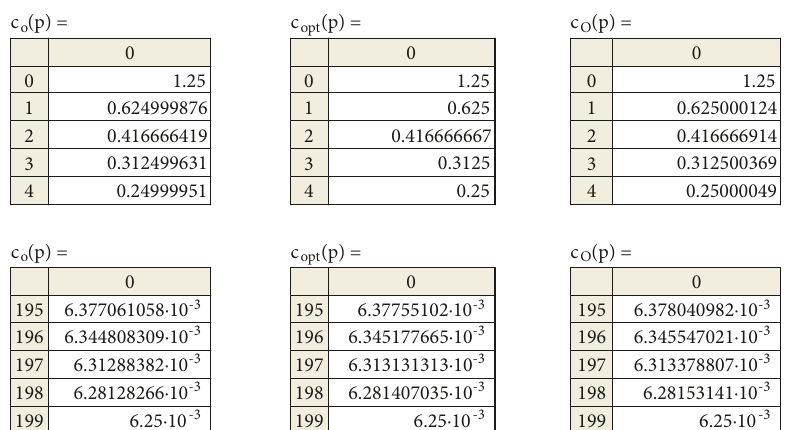
Figure 7: Initial and final values of the variated determining free